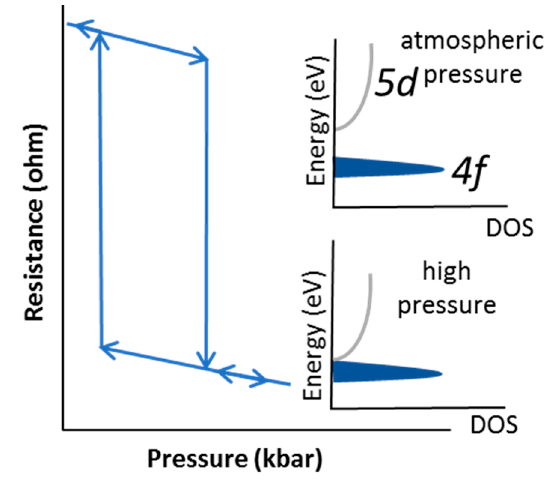
Figure 1. Schematic representation of the piezoresistive response of single crystal SmS. At the critical pressure, a change from the high-resistive to the low-resistive state occurs, due to the pressure induced shift of the 5d conduction band towards the 4f states of Sm 2 + (inset). The top inset shows the gap between the 4f states and 5d conduction band at atmospheric pressure. The bottom inset demonstrates the closing of the gap, upon application of pressure. Upon release of the pressure, the SmS returns to the high-resistive state.